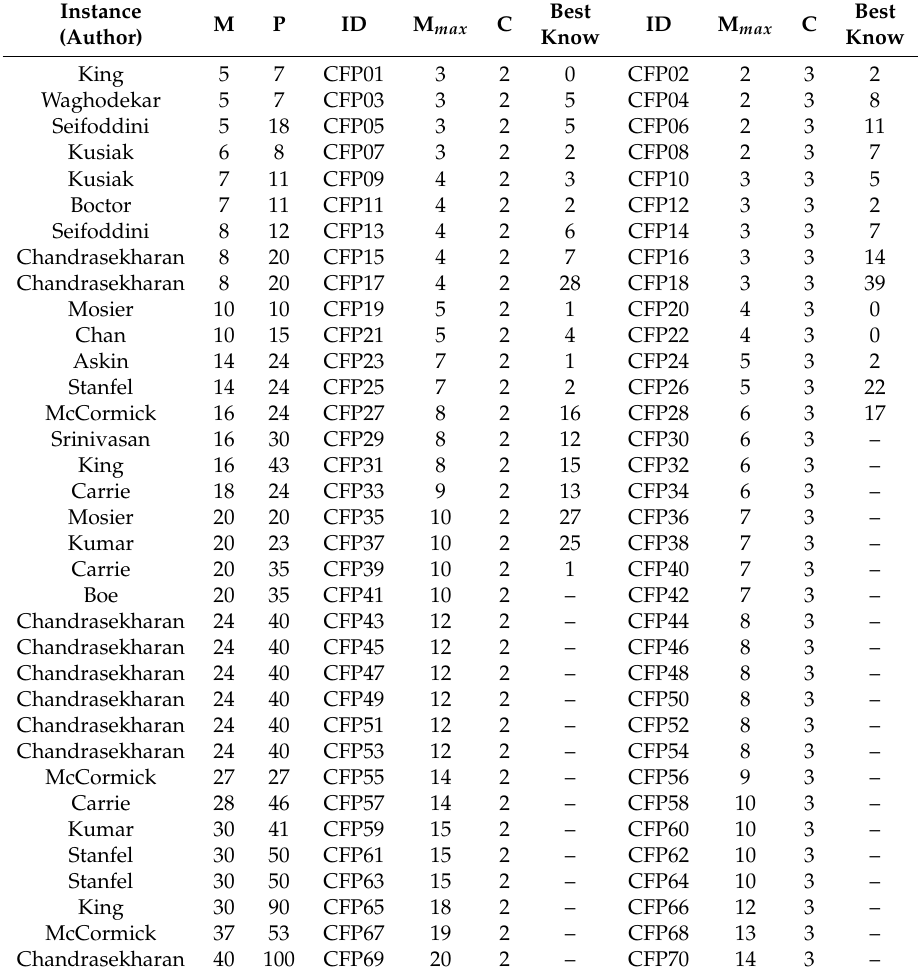
Table 5. A set of complex instances from several